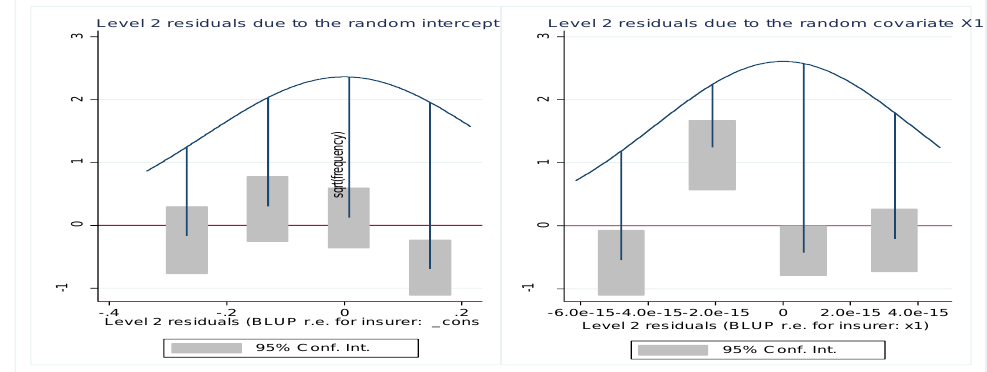
Figure 6: Rootogram for level-2 residuals; Assurance Customer satisfaction